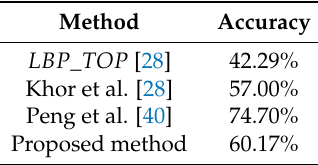
Table 8. Comparison between our method and those of other top-performers from